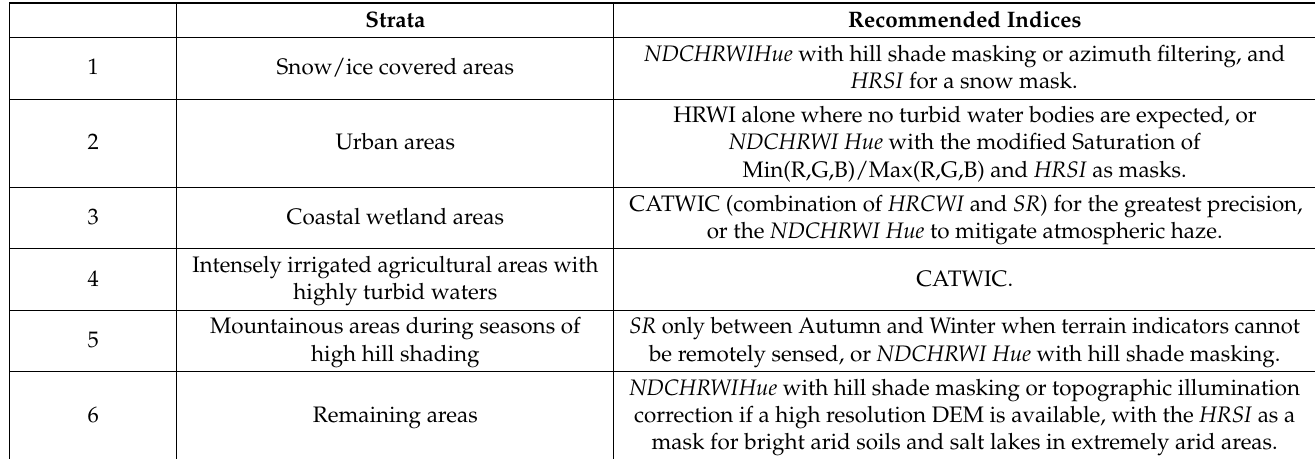
Table 12. Proposed global stratification for hydrologic mapping and monitoring for sensors limited to the visible and NIR